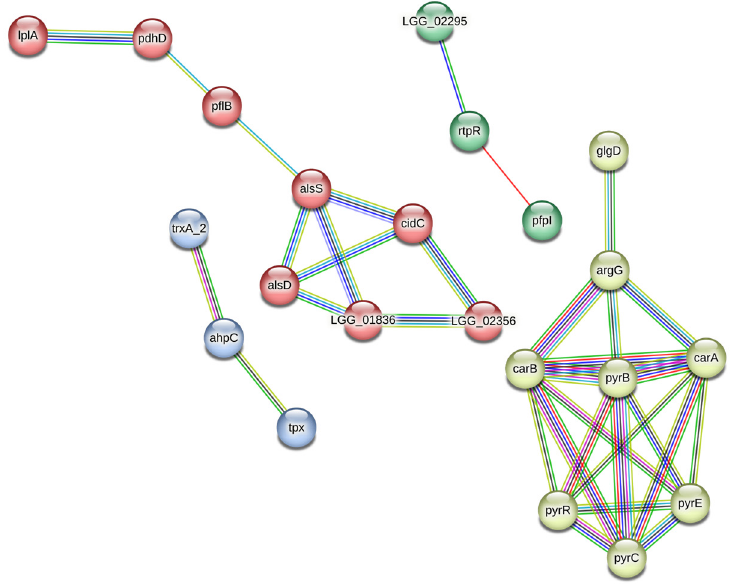
Figure 1. Protein–protein interaction network of differentially abundant proteins in L. rhamnosus CM MSU 529. Known interactions: ( ▬ ) from curated databases, ( ▬ ) experimentally determined. Predicted interactions: ( ▬ ) gene neighborhood, ( ▬ ) gene fusions, ( ▬ ) gene co-occurrence. Others: ( ▬ ) textmining, ( ▬ ) co-expression, ( ▬ ) protein homology. Clusters: ( ● ) 1, ( ○ ) 2, ( ● ) 3, ( ● ) 4. LGG_01836 ( pox ), LGG_02356 ( lctO ), and LGG_02295 (LRHMDP2_2713).